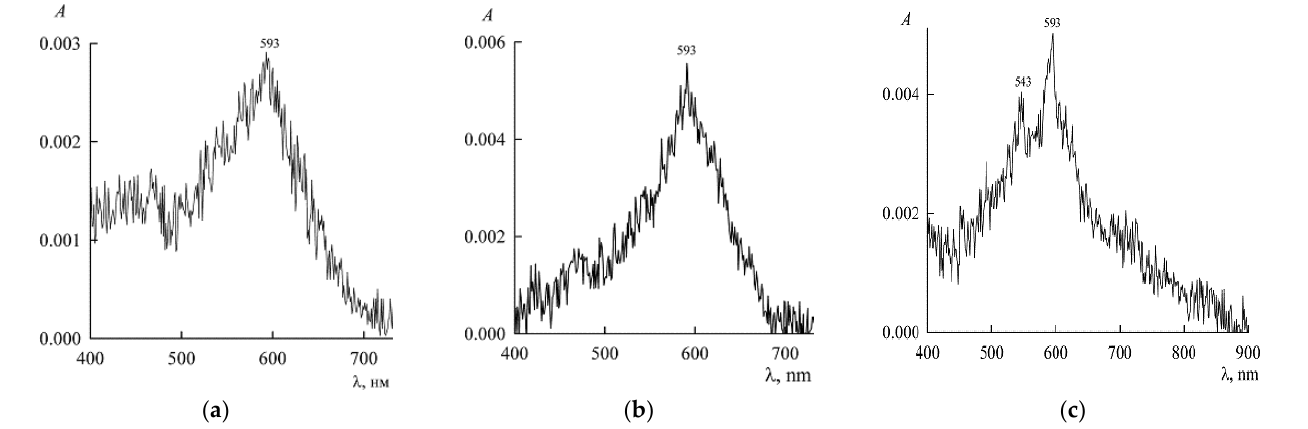
Figure 2. Absorption spectra of NR in a dispersion with water with a gross concentration of 2.5 µ M after 1 day ( a ), 7 days ( b ), and 16 days ( c ) after preparation ( A is optical density, λ light length).